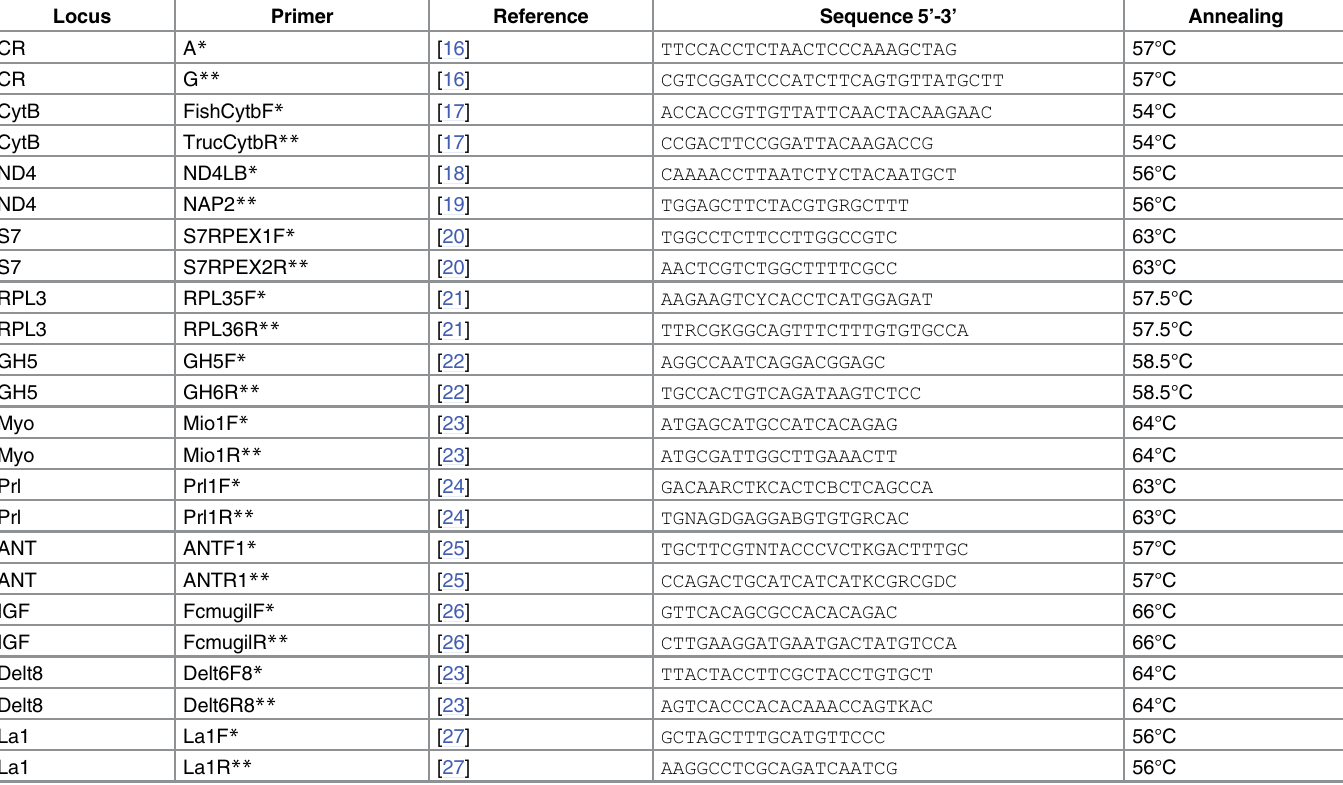
Table 1. Description of primers and amplification conditions for all the genomic segments used in this study. * - Forward primer, ** - Reverse primer.